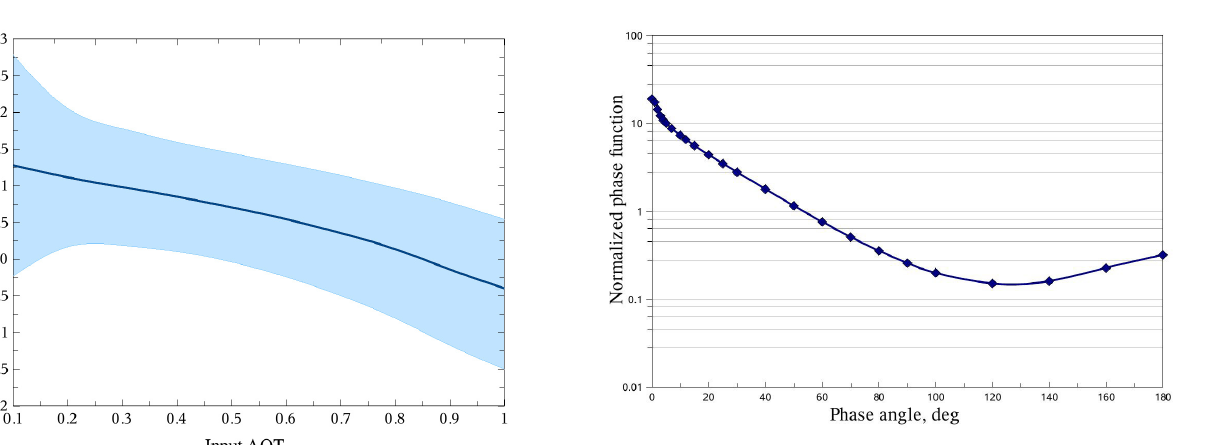
Fig. 6. The relative error of the retrieved AOT for a given input AOT (blue line). The color filled area shows the sensitivity of the retrieved AOT to the AATSR BT calibration error of ± 0.1K.